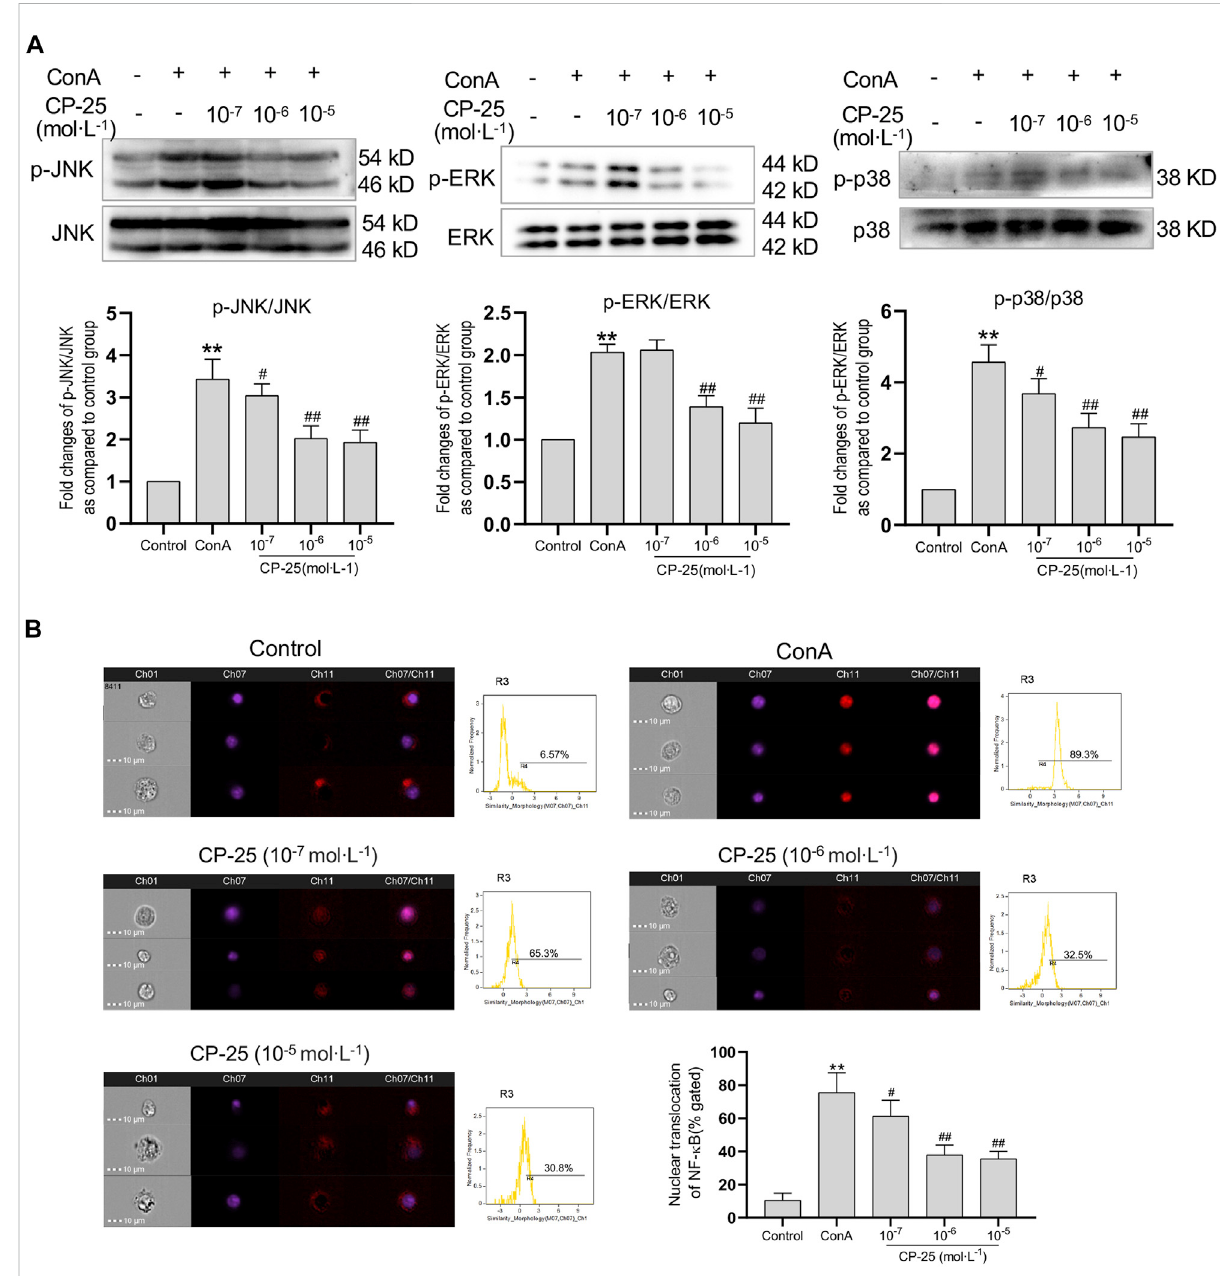
CP-25 suppressed ROS in fl uenced MAPK pathway activation and NF- κ B nuclear translocation in RAW264.7 cells. (A) Representative immunoblotting bands of p-JNK, p-ERK and p-p38 in ConA-stimulated RAW264.7 cells. Data were expressed as-fold change relative to the control group, which was assigned as a value of 1. (B) NF- κ B nuclear colocalization in CP-25-administrated RAW264.7 cell was analyzed by image fl ow cytometry,andrepresentativeimageswereshownincludingbright fi eld,NF- κ B(red),nucleus(purple),andmergedimages(Scalebars=10 μ m), and statistic results were shown. ** p < 0.01 versus control, # p < 0.05, ## p < 0.01 versus ConA. Data were expressed as the mean ± SD from three independent